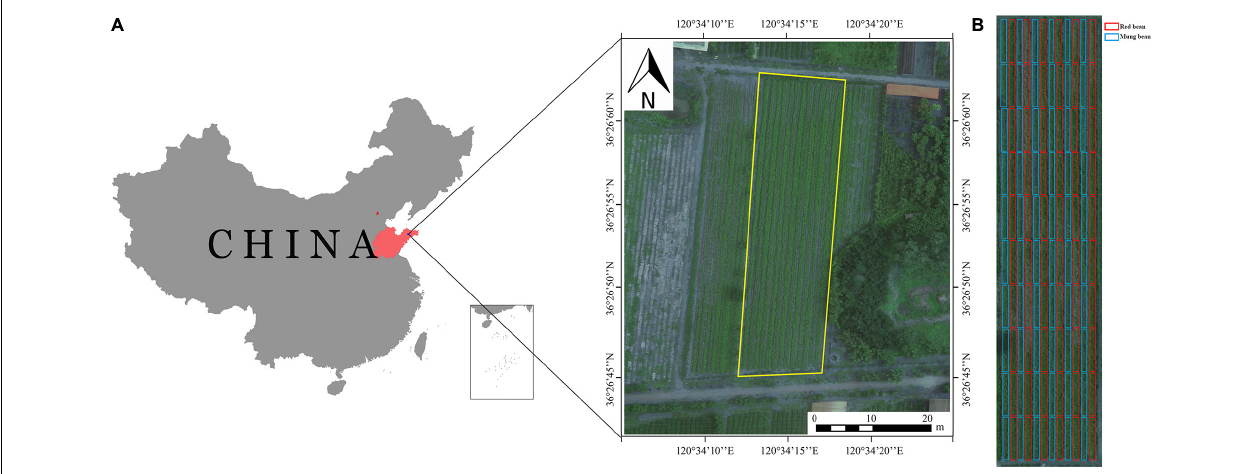
FIGURE 1 | Research area. (A) The location of the experiment area; (B) experimental